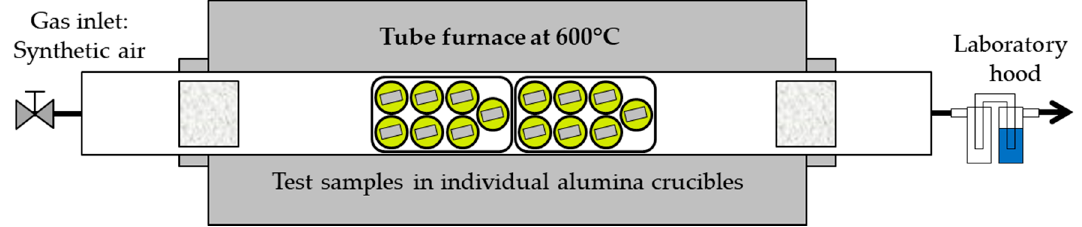
Figure 1. Schematic illustration of the corrosion test rig for exposure in molten solar salt at 600 °C.